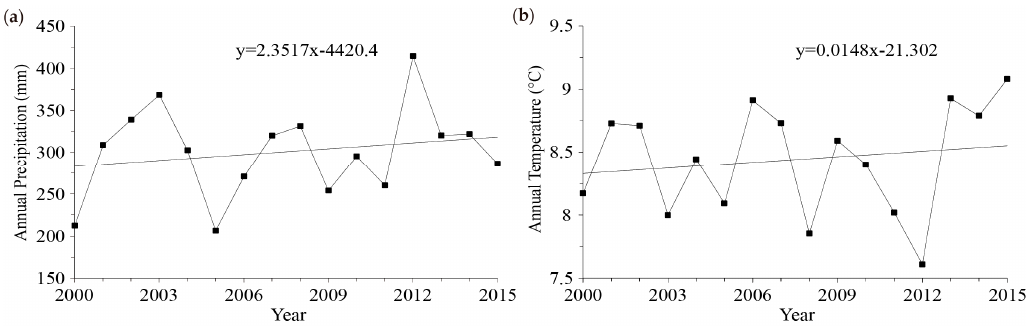
Figure 9. The trends of ( a ) annual precipitation and ( b ) temperature in the study area from 2000 to 2015 using the averaged data acquired from meteorological stations.